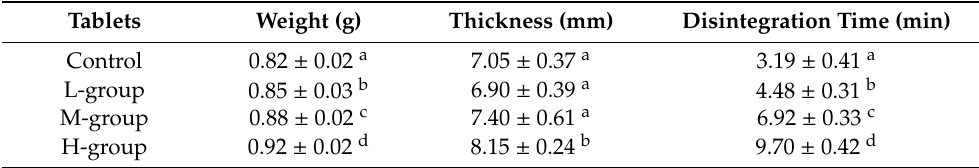
Table 2. Weight, thickness and disintegration time of the lactobacilli e ff ervescent tablets supplemented with di ff erent contents of Chinese ginseng and Polygonatum sibiricum.